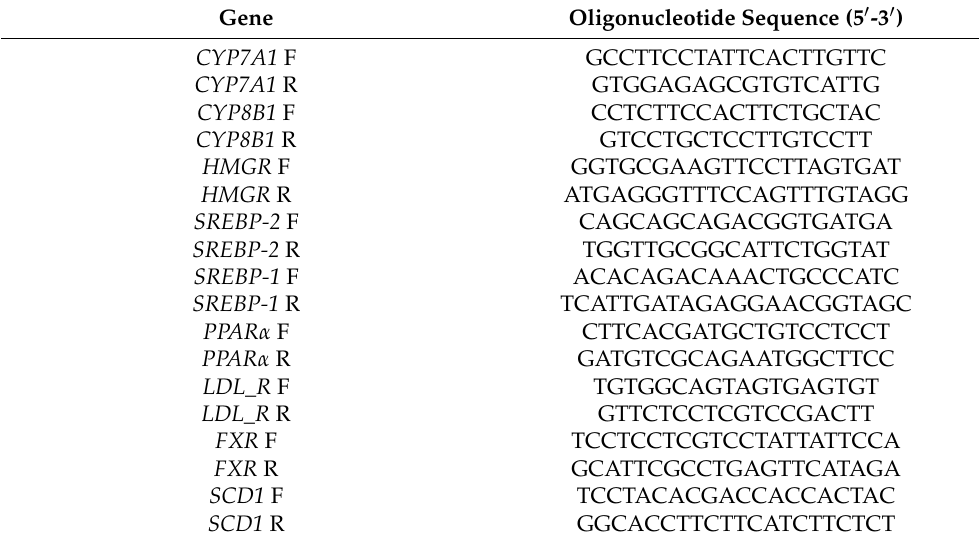
Table 1. Primer sequences of related